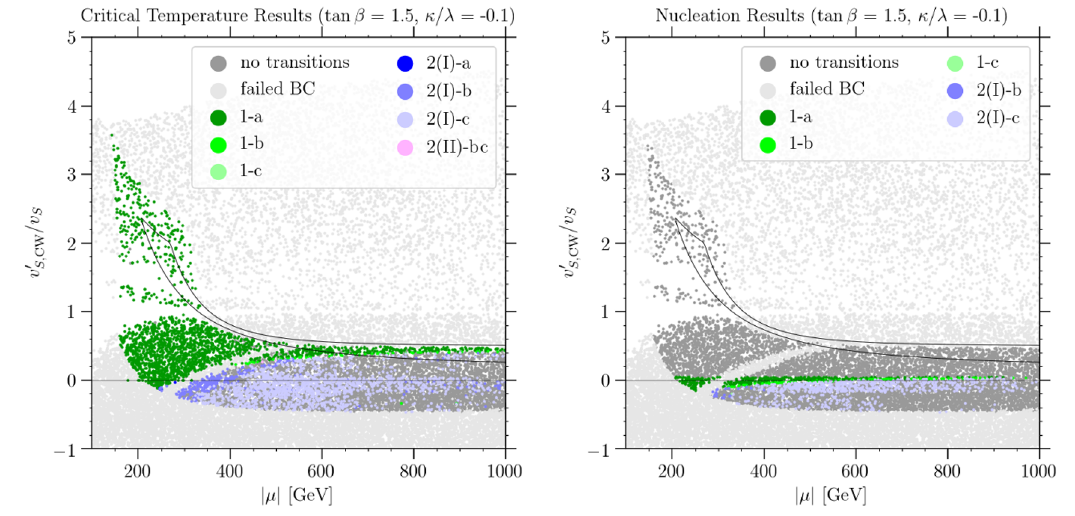
Figure 4 . Results from our parameter scans in the | µ | vs. v 0 /v S plane for the same slice of S, CW parameter space as shown in the left panel of figure 1: tan β = 1 . 5 and κ/λ = − 0 . 1 . The left panel shows points categorized according to the phase transition patterns suggested by the critical temperature calculation. In the right panel, points are instead categorized by the thermal histories obtained from the nucleation calculation. For points labeled “no transition”, CosmoTransitions did not return a transition chain starting in the trivial minimum at high temperatures and ending in the physical minimum at zero temperature, and points labeled “failed BC” do not satisfy our boundary conditions defined in the text. The solid lines enclose the region of parameter space for which we find feasible zero-temperature vacuum structure in section 2.3. These bounds are obtained from tree-level relations, hence, for these bounds, the y -axis is v 0 = − ( µ/λ + A 2 κ ) /v S , where v 0 κ / S S is the location of an extremum of V eff in the singlet-only 0